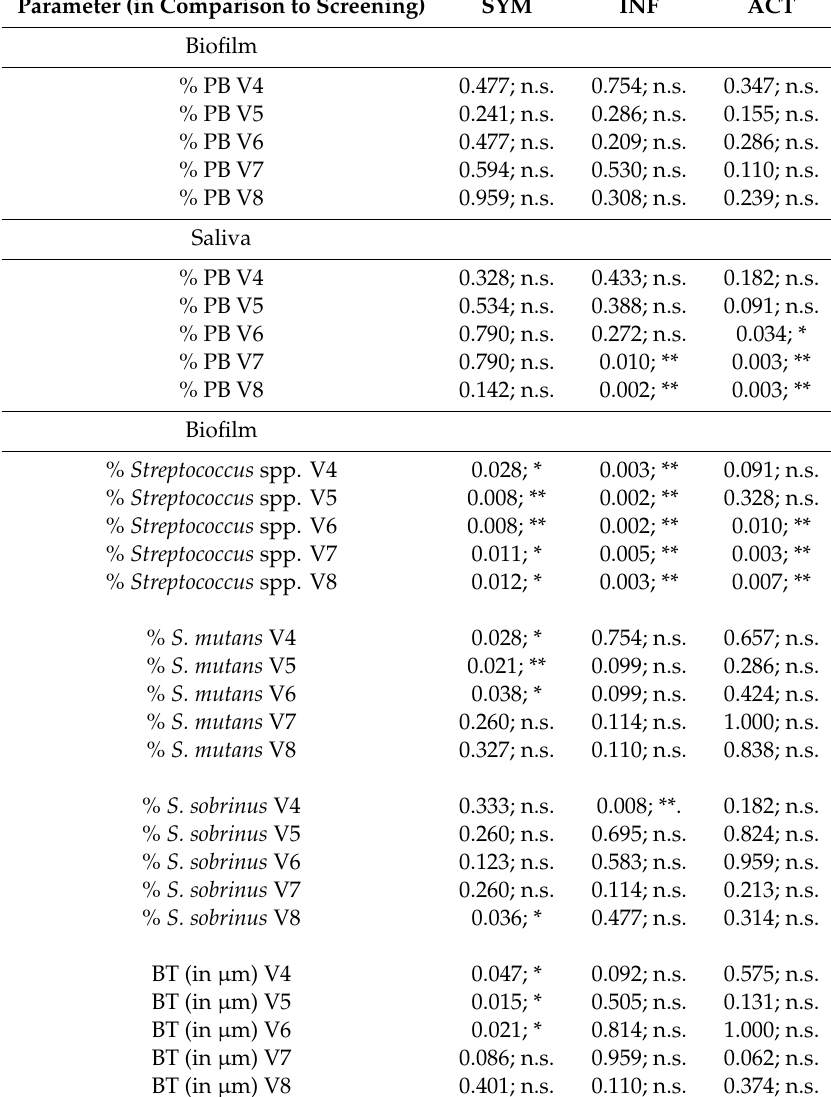
Table 1. Statistical analysis ( p -value) of all parameters, comparing visits with screening period in the di ff erent